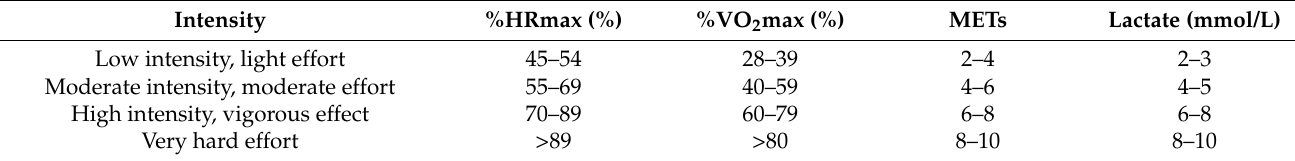
Table 1. Measurement of exercise intensity. Adapted from Vanhees et al. [31].